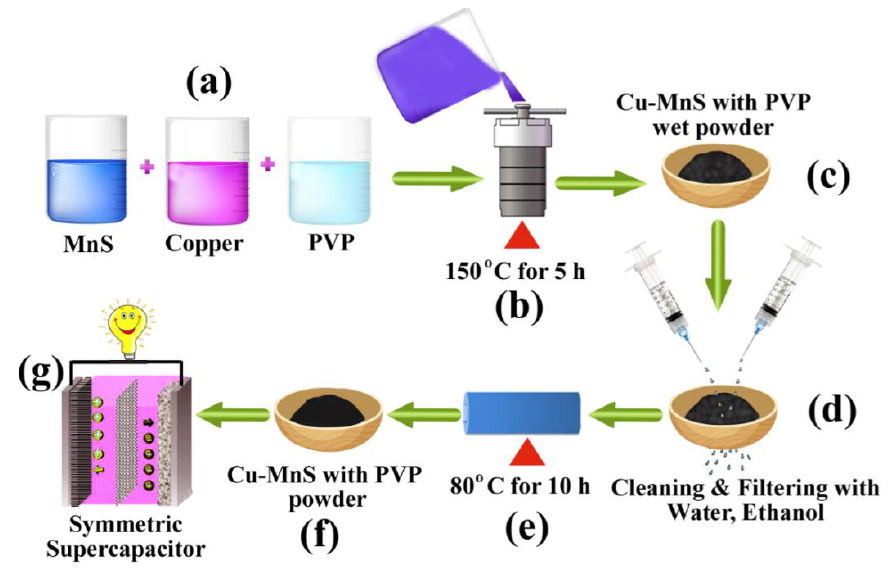
Figure 1. Illustration of the synthesis route for Cu-MnS with PVP nanocomposite.